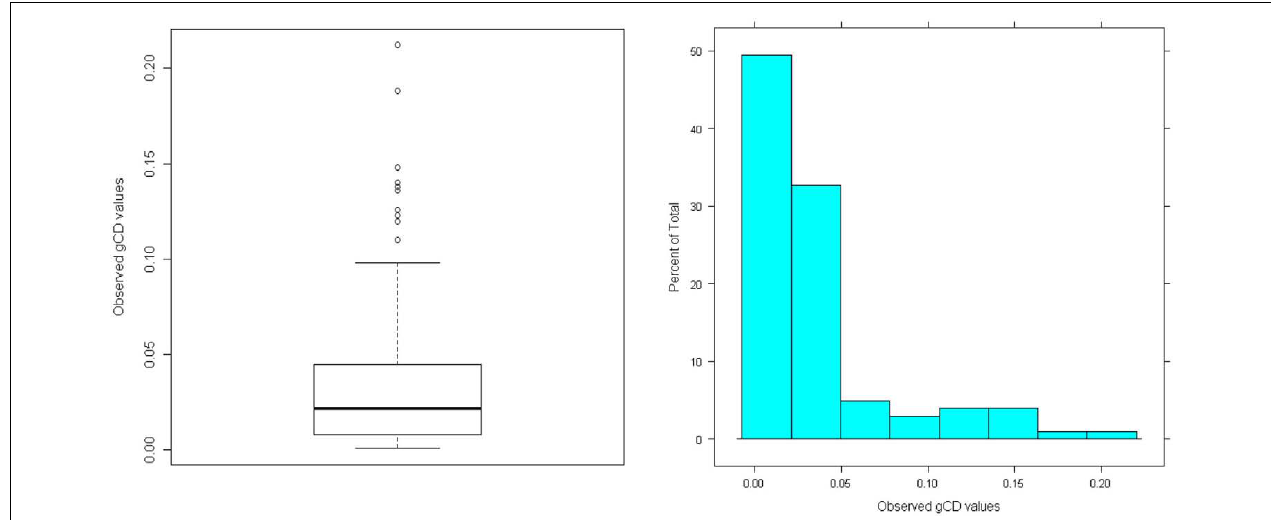
FIGURE 4 | Distribution of generalized Cook’s distance (gCD) for multivariate normal random sample data ( N = 100; no unusual